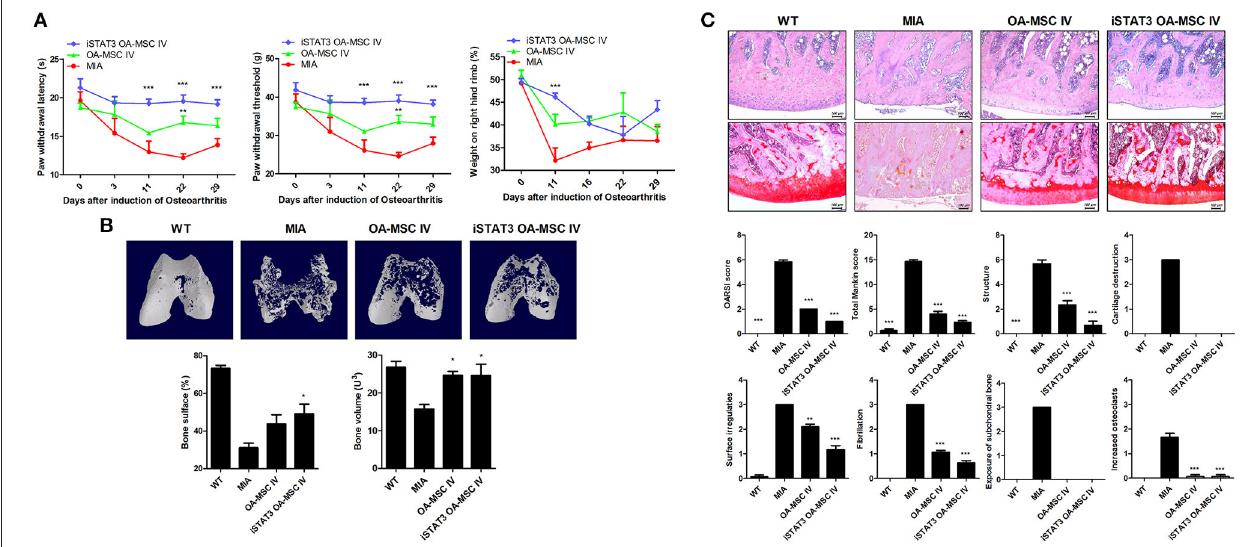
FIGURE 3 | Reduced severity by IV administration of iSTAT3 OA-MSCs in MIA-induced OA rats. (A) OA was induced in Wistar rats by IA injection of MIA. OA rats were injected IV with OA-MSCs (6 × 10 5 ) or iSTAT3 OA-MSC (6 × 10 5 ). OA-MSC were isolated of fat tissues obtain from each 3 person with OA. Pain behavior was assessed as mechanical hyperalgesia measured with a dynamic plantar esthesiometer and incapacitance meter, and was quantified as PWL and PWT ( n = 3 per group). (B) Representative micro-CT images of the femoral condyles at 4 weeks in all groups. Object volume (Obj.V) and bone surface (%) measured in micro-CT images from femurs. (C) Histochemical analysis of femoral condyle and severity scores after IV administration of iSTAT3-OA MSCs in MIA-induced OA rats. Knee joint tissue samples were acquired at 4 weeks from wild-type (WT) rats, rats with MIA-induced OA, rats that received IV OA-MSCs, and rats that received IV iSTAT3 OA-MSCs, and were stained with H&E and Safranin O to evaluate the severity of inflammation and cartilage damage (* P < 0.05; ** P < 0.01; *** P <